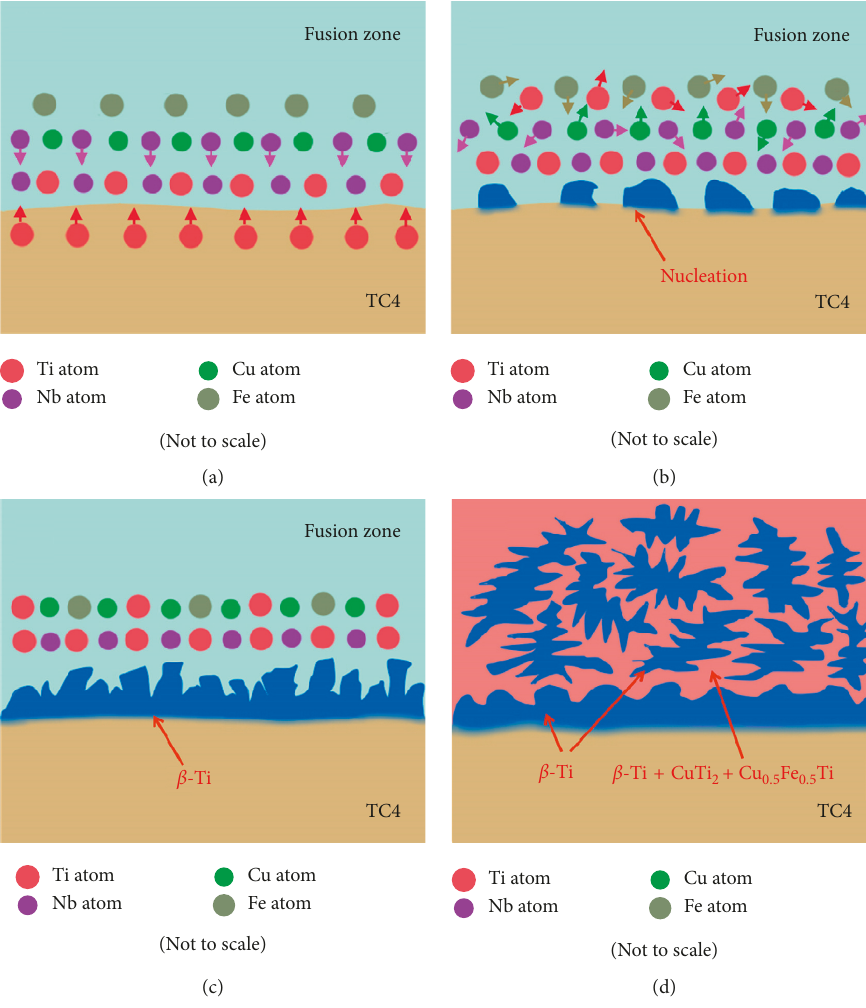
Figure 11: Formation process of the fusion zone of the titanium alloy side: (a) surface contact; (b) element diffusion and nucleation; (c) growth of grains; (d) formation of the solid solution and